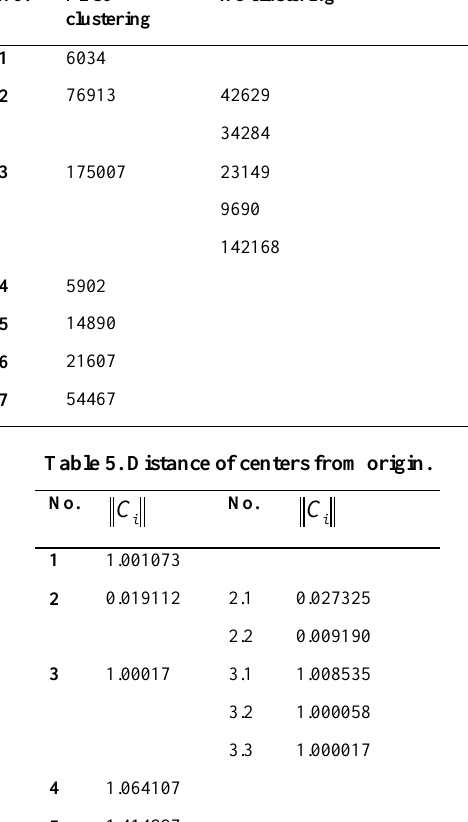
Table 4. Number of members of obtained cluster. No.